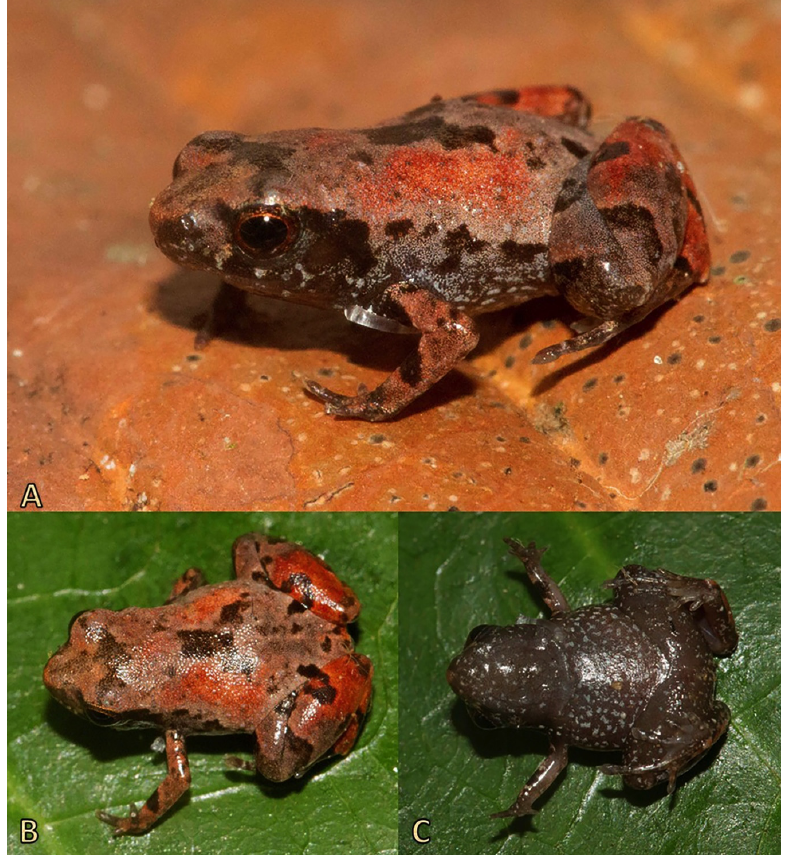
Figure 3. Photographs of live specimen of Noblella losamigos sp. n. ( A , B , C ) Adult male paratype MUSM 37355 (SVL 9.5 mm). Photographs by Rudolf von May.